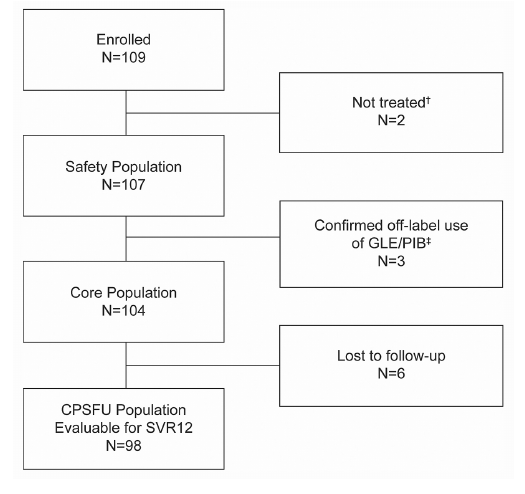
Figure 1: Patient disposition.† Consent withdrawn (1 patient), lost to follow-up after baseline visit (1 patient).‡ Treatment-naïve and non-cirrhotic patients treated for 12 weeks (2 patients), received previous direct-acting antiviral treatment (1 patient).GLE = gle- caprevir; CPSFU = core population with sufficient follow-up data; N = number of patients; PIB = pibrentasvir; SVR12 = sustained viro- logical response 12 weeks after completion of